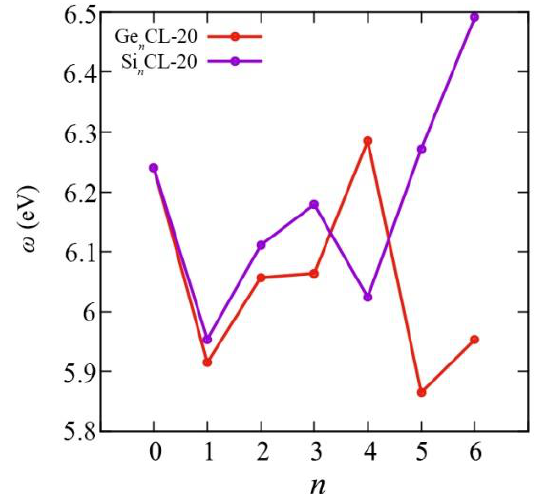
Figure 10. The electrophilicity ω versus the number of Si-/Ge-atoms n in the Si n CL-20/Ge n CL-20 molecules for the most thermodynamically stable configurations obtained at the DFT/B3LYP/6- 311(d,p) level of theory.